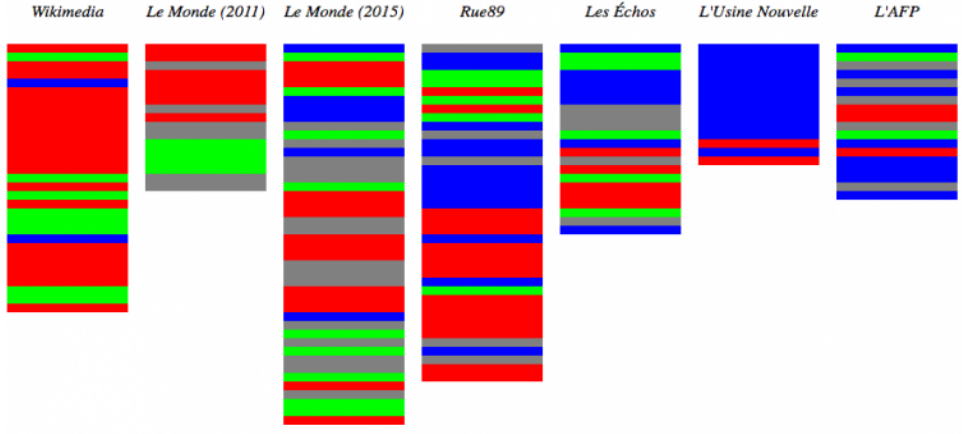
Figure 5: A closer look at the corpus Unsurprisingly, the (aggregated) five small articles published by Wikimédia France on Libertédepanorama.fr in 2016 and the 2011 Wikimedian op-ed published on Le Monde easily stand out among the reddish pieces of our corpus. Generalist media extend the Wikimedian intricate discourse into more diversified texts. A Rue89 article of June 2015 combines both